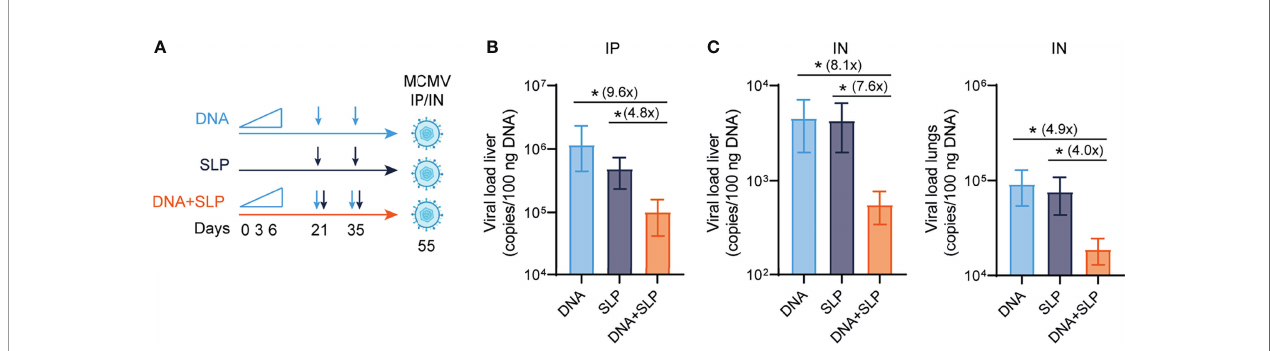
FIGURE 4 | The combination of sgB DNA vaccines with the CD8 + T cell eliciting synthetic long peptide vaccines is superior in protection against MCMV. (A) Vaccination schedule for mice vaccinated with the sgB DNA vaccine and/or the SLP vaccine. The sgB DNA vaccine was intradermally with an increasing dose prime schedule (10 µg on day 0, 20 µg on day 3 and 30 µg on day 6) followed by two booster immunizations with 60 µg. The SLP vaccine (synthetic long peptides containing the M38 and m139 class I epitopes, adjuvanted with CpG) was provided subcutaneously on day 21 and day 35. Three weeks after the fi nal vaccination, mice were challenged either intraperitoneally or intranasally with 5 × 10 4 PFU salivary gland-derived MCMV-Smith. (B) At day 5 post intraperitoneal infection, livers were isolated. The viral genome copies were determined by PCR. The viral load is depicted as mean values ± SEM (n=8). (C) At day 5 post intranasal infection, livers and lungs were isolated. The viral genome copies were determined by PCR. The viral load is depicted as mean values ± SEM are shown (n=8). Experiments was performed twice with similar outcome. A Kruskal-Wallis test was used for statistical analysis.